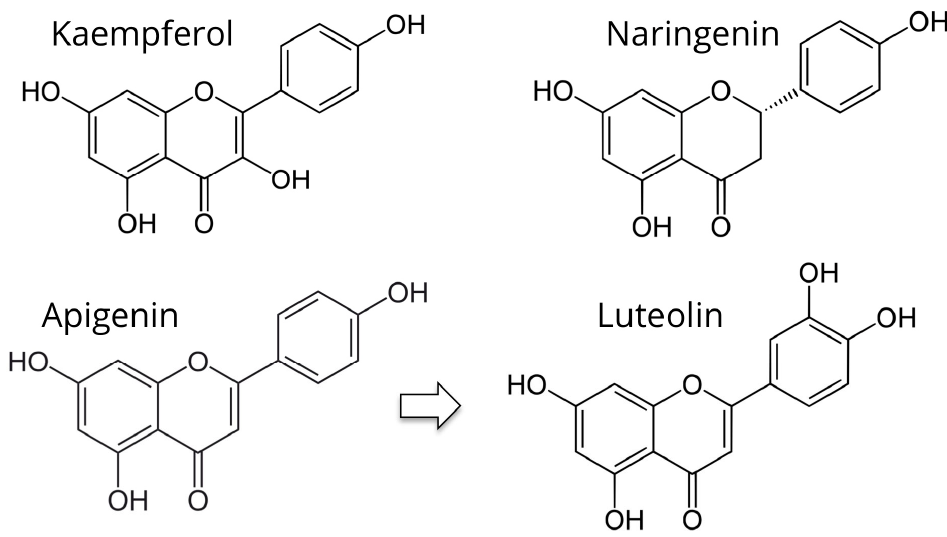
Figure 3. Chemical structure of phytoprogestins.